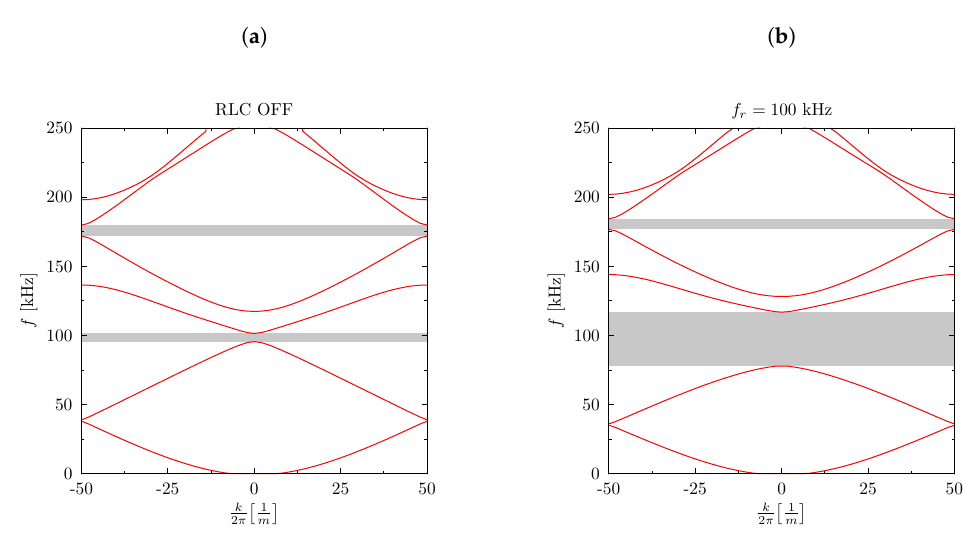
Figure 8. Dispersion curves for the analysed beam, ( a ) RLC circuits off, ( b ) RLC circuits tuned to 100